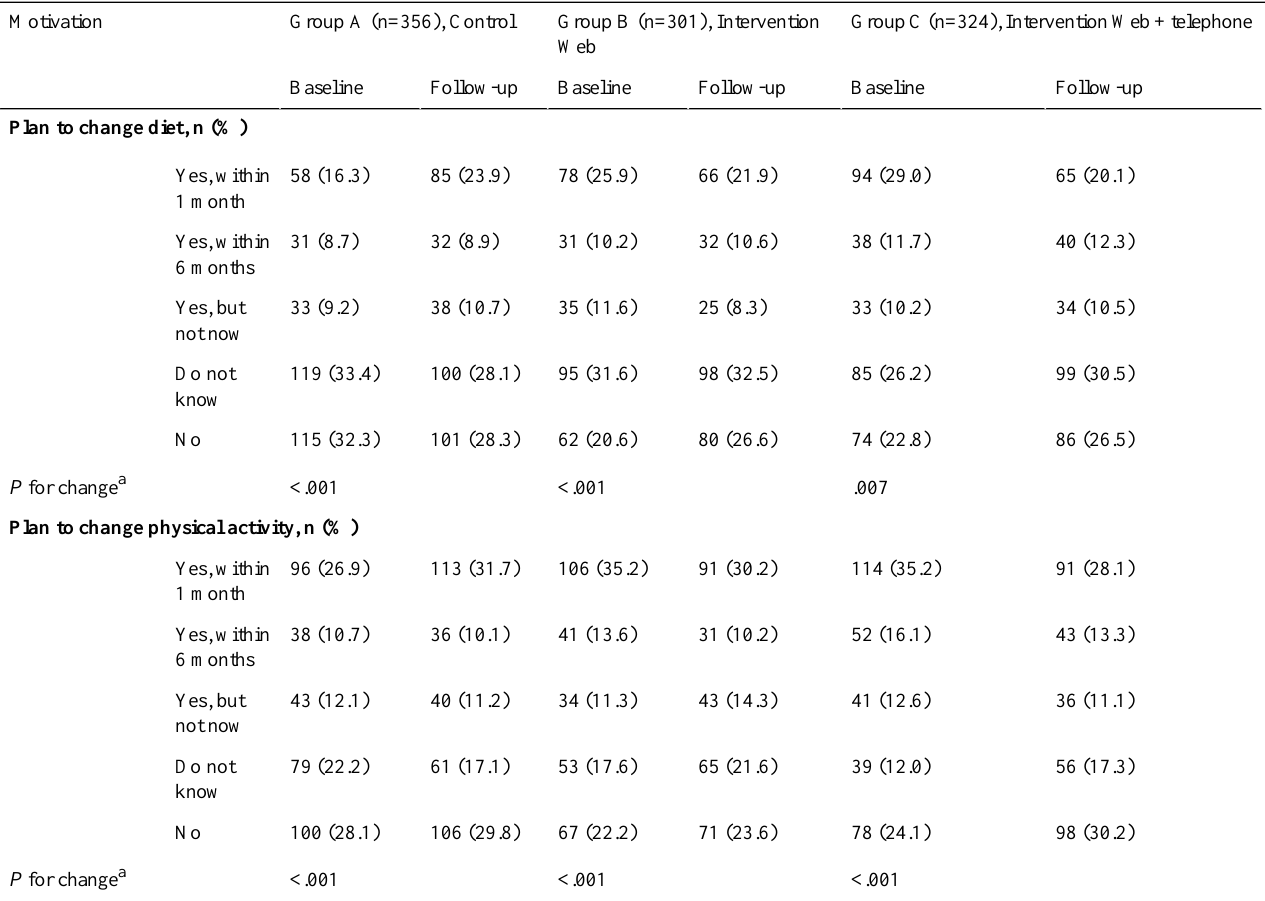
Table 2. Motivation to change diet and physical activity at baseline and follow-up across